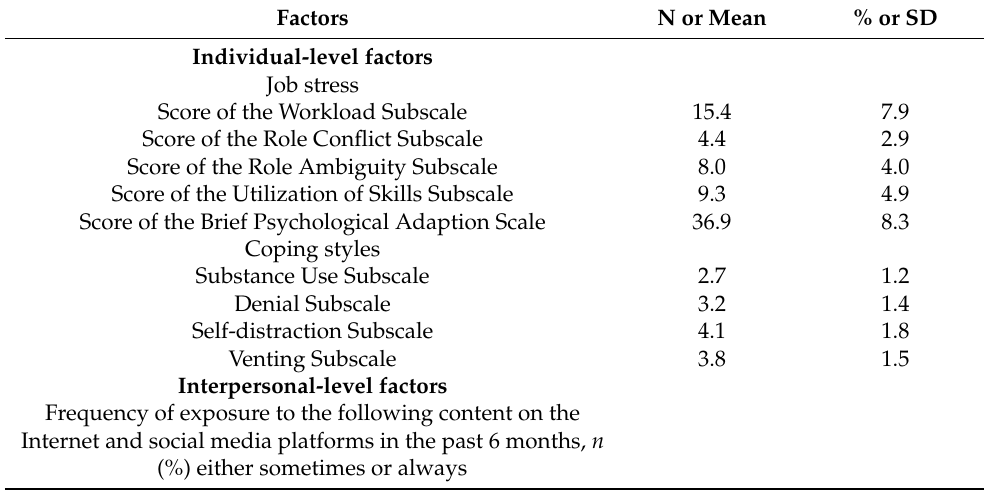
Table 2. Item responses and scale scores of variables at individual and interpersonal levels ( n =